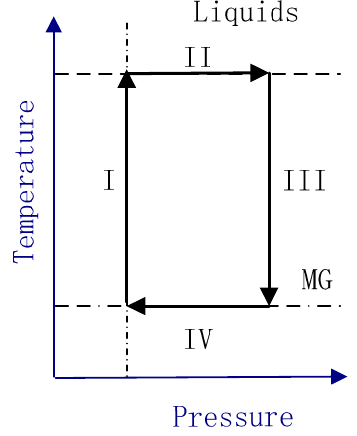
Figure 1. Schematic illustration of the four pathways to glass formation employed in the computer simulation studies.